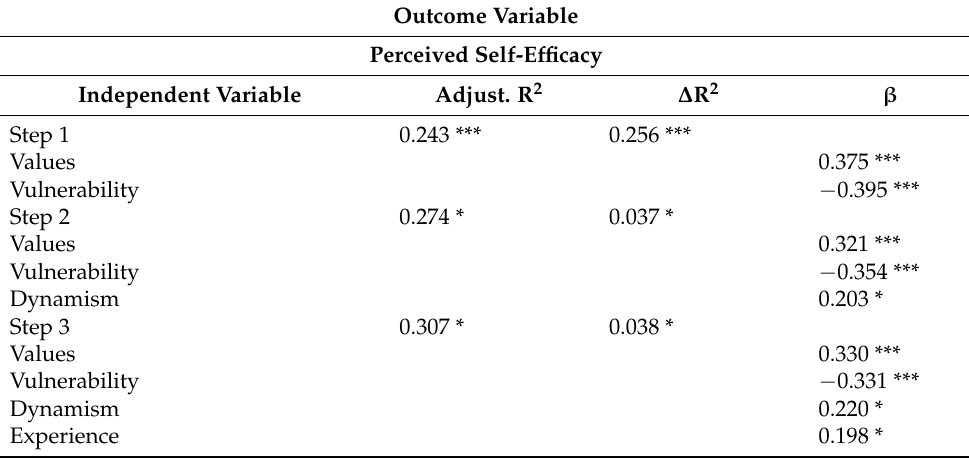
Table 7. Results of Hierarchical Linear Regression Analyses of Clown Therapists working in Pairs.